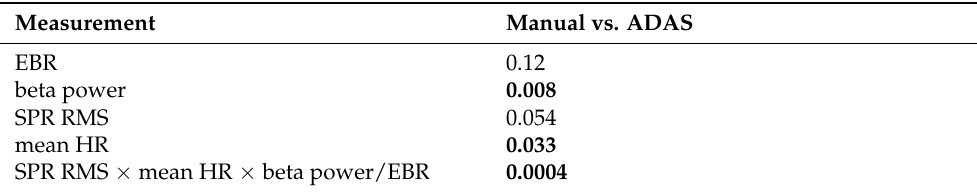
Table 5. Paired Wilcoxon test probability p considering Manual versus ADAS scenarios using different physiological measurements (EBR, beta power, SPR RMS, mean HR, and SPR RMS × mean HR × beta power/EBR) computed for all